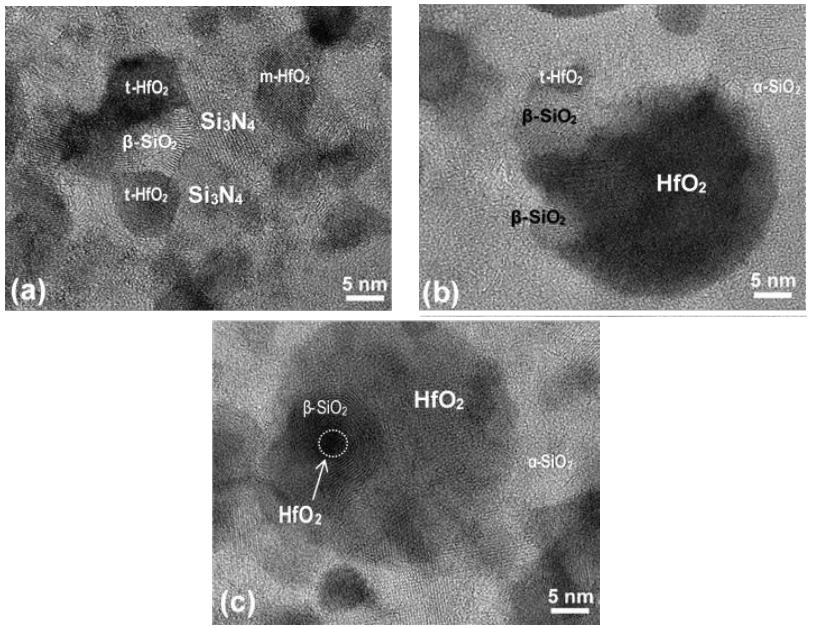
Figure 7. Plan-view HRTEM images taken from the oxide / transition layer interface in the annealed Hf 6 B 10 Si 31 C 2 N 50 film ( a – c ).